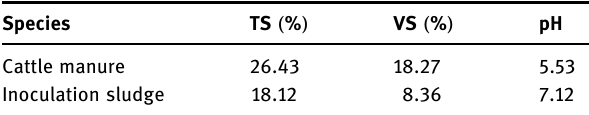
Table 1: Basic properties of cattle manure and inoculated sludge